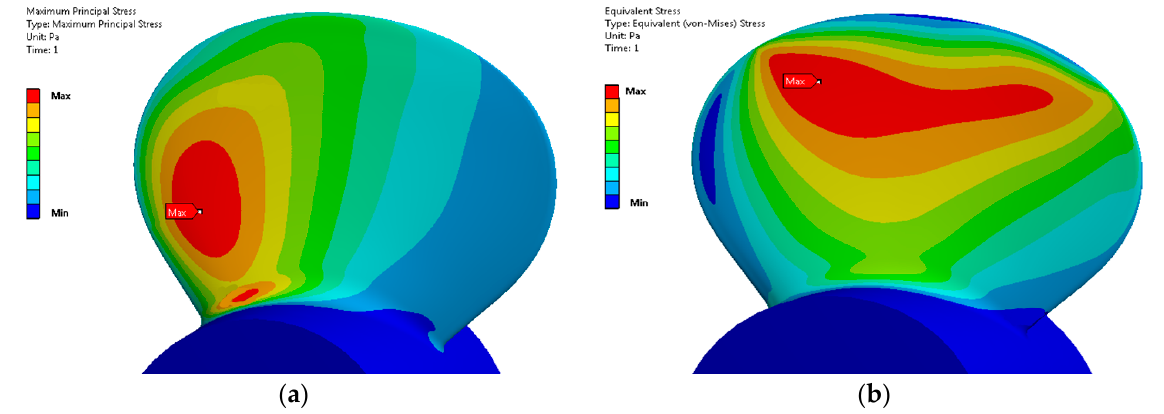
Figure 15. Principal stress fields on the pressure side of the icebreaker blade [7]: ( a ) backward force F b (the first type of ice milling); ( b ) forward force F f (the second type of ice milling). Taking the latter into account, the permissible fatigue stress values (stress range) σ perm f are determined according to the formula